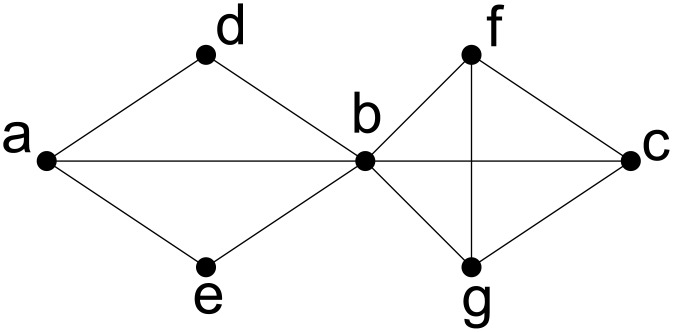
Edge connectivity in undirected graphs.